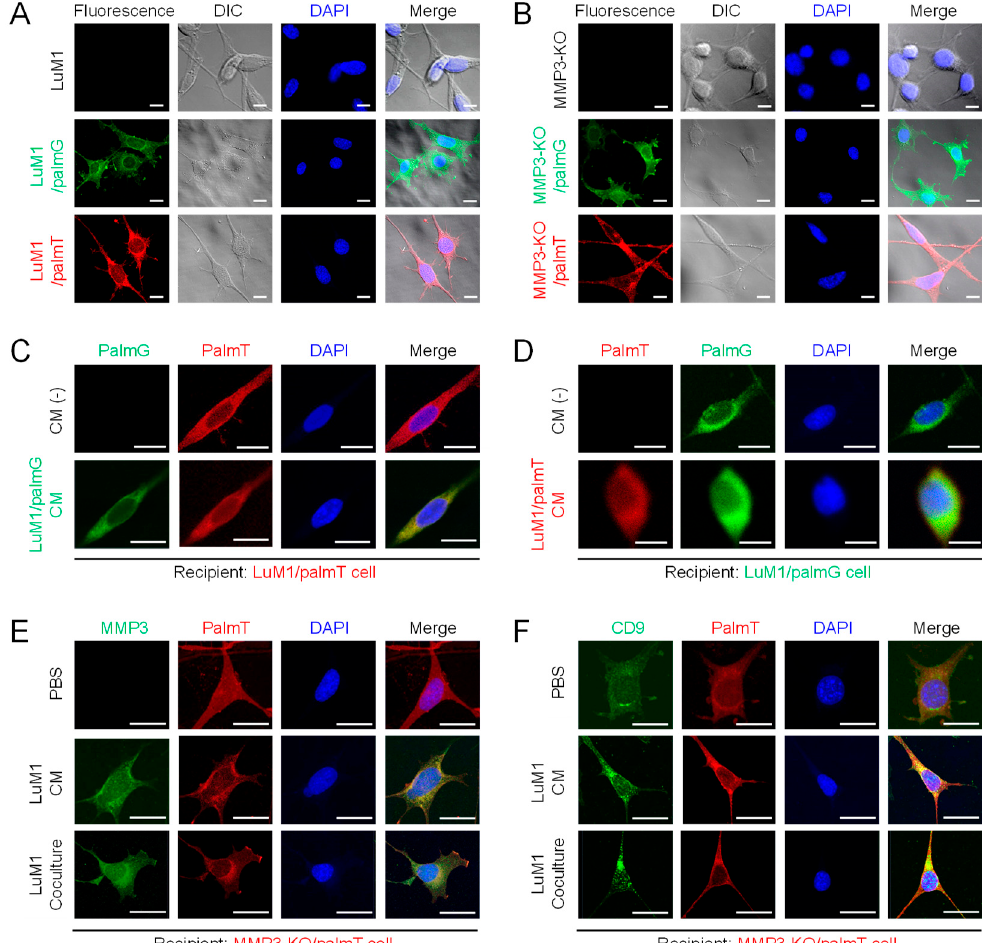
Figure 7. Establishment of fluorescent-labeled LuM1 and MMP3-KO cells. ( A , B ) Fluorescent labeled ( A ) LuM1 and ( B ) MMP3-KO cells. The stable cells were established by the transfection of expression constructs for palmT (red) and palmG (green) fluorescent proteins tagged with the palmitoylation signal. Images were taken using confocal laser scanning microscopy (CLSM). Non-fluorescent LuM1 and MMP3-KO cells were used as negative controls. ( C , D ) Molecular transfer of ( C ) palmG- and ( D ) palmT-labeled EVs from the conditioned medium (CM) of donor cells to recipient cells. ( C ) LuM1 / palmT cells were treated with / without the CM of LuM1 / palmG cells. ( D ) LuM1 / palmG cells were treated with / without the CM of LuM1 / palmT cells. ( E , F ) Immunostaining of ( E ) MMP3 and ( F ) CD9 in recipient MMP3-KO / palmT cells stimulated with PBS, LuM1-CM, or coculturing with LuM1 cells in the Transwell system. DNA was stained with DAPI (blue). DIC, di ff erential interference contrast. Scale bars, 20 μ m. The experiments were repeated twice.